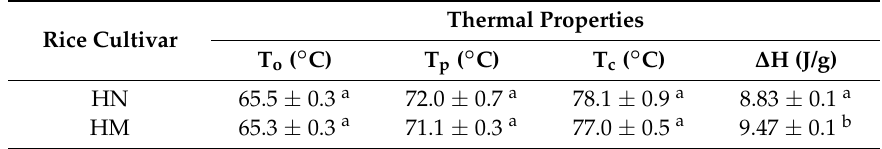
Table 1. Thermal properties of Hom Nil rice flour (HN) and Hom Mali 105 rice flour (HM).